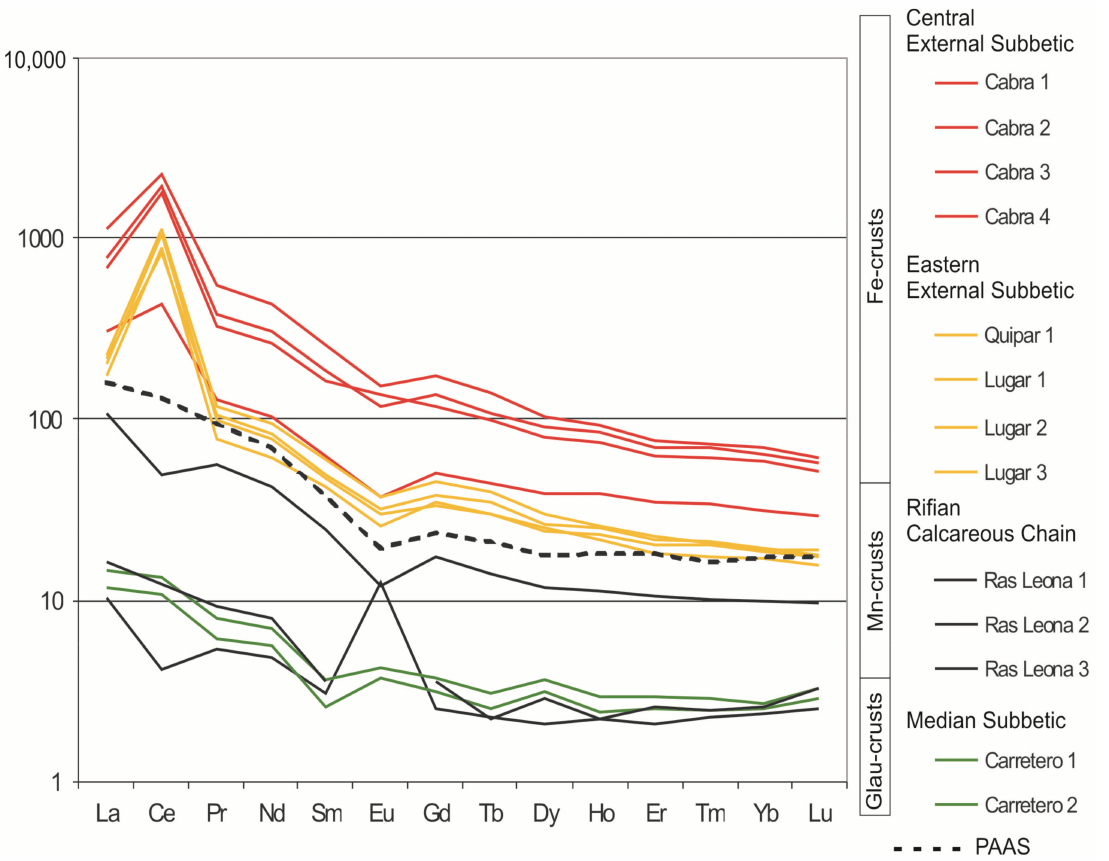
Figure 7. Rare earth elements (REE) of the different microbial crusts studied in this work normalized to the carbonaceous chondrite [113], and compared with the composition of the Post-Archaean Australian Shales (PAAS) [112] representative of the upper continental crust. Observe the positive anomaly in Ce for iron crusts and macro-oncoids from the External Subbetic respect to the PAAS. In the case of the Mn-crust of the Rifian Calcareous Chain (Jbel Moussa Group), a negative anomaly of Ce is observed, whereas Eu shows an anomaly in one sample but the trend in the other samples is parallel to the REE pattern in the PAAS. With respect to the green laminated crusts composed by glauconite micas, the trend is similar than in the PAAS, except for a low negative anomaly in